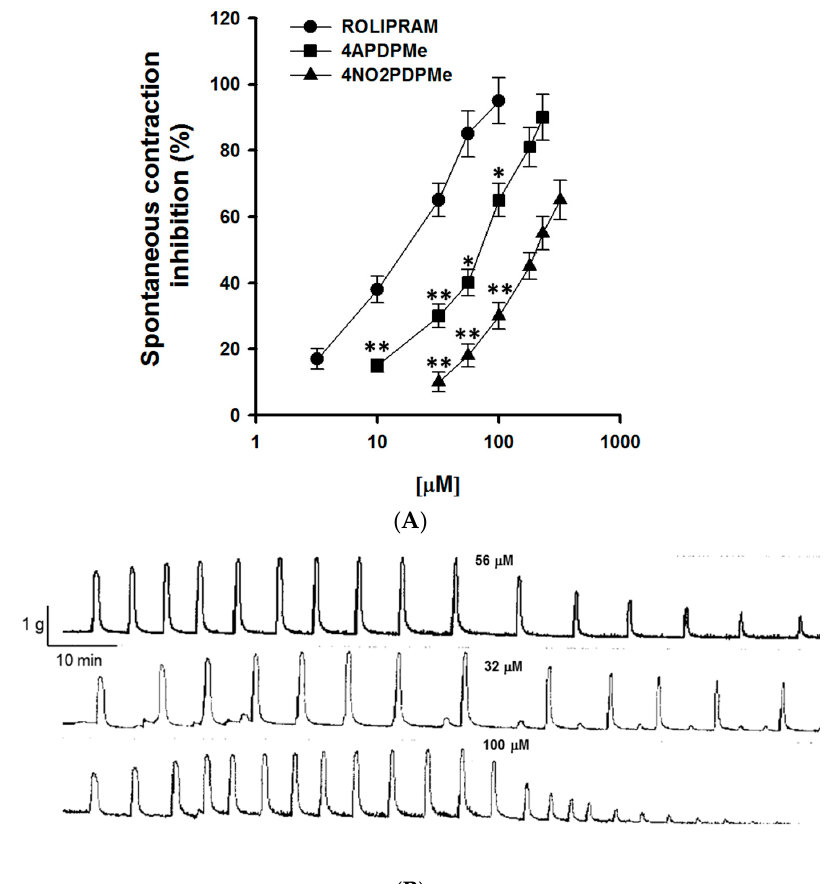
Figure 1. Inhibitory effects of rolipram and thalidomide analogs on the spontaneous contraction of pregnant human myometrium. ( A ) Concentration-effect curves of rolipram, 4NO2PDPMe and